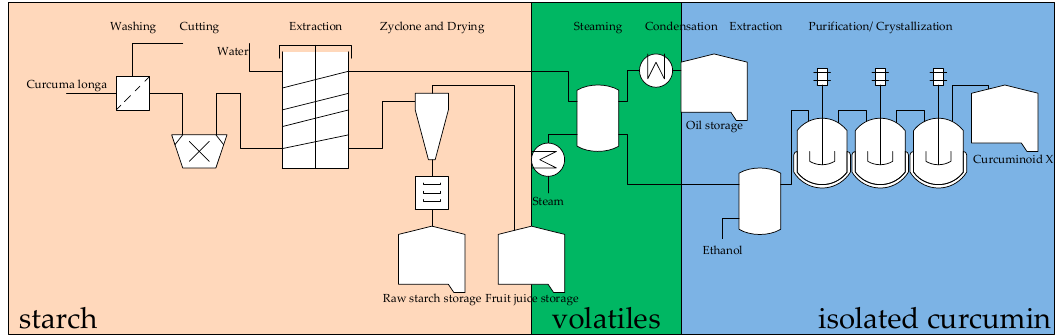
Figure 8. Large-scale process for the extraction of starch, etheric components, and Figure 8. Large ‐ scale process for the extraction of starch, etheric components, and curcumin.